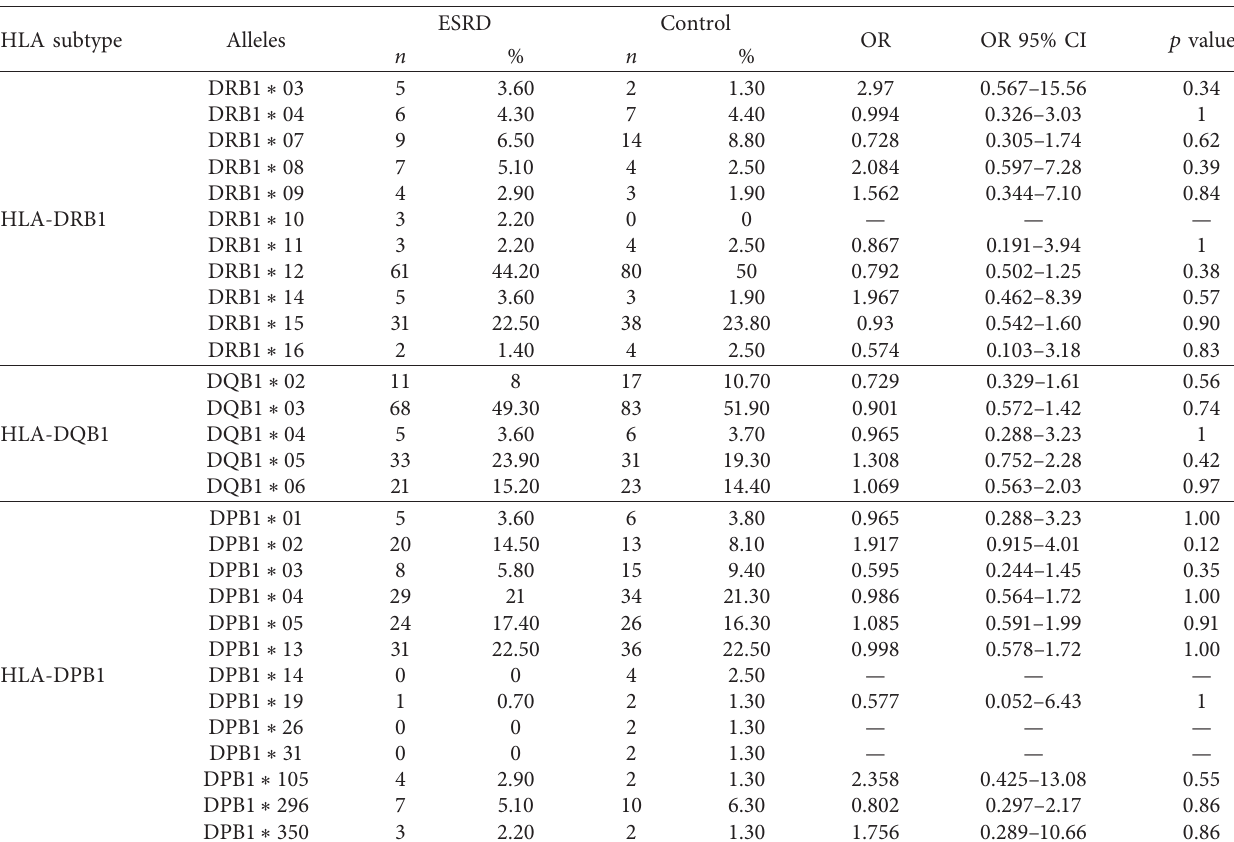
Table 2: HLA class II allele frequency.